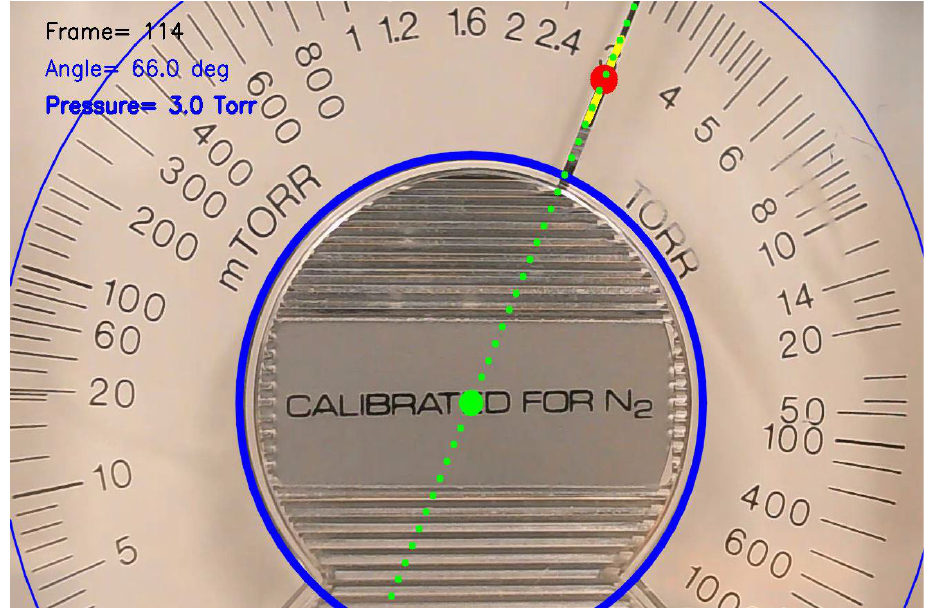
Figure 5. Sample frame from computer vision-based gauge reading system [38] (blue—dial circum- ference detected with Hough circle transform; yellow—gauge arrow pointer detected with grayscale threshold; red—middle part of the arrow pointer; green—direction to the arrow pointer according to the calculated angle of